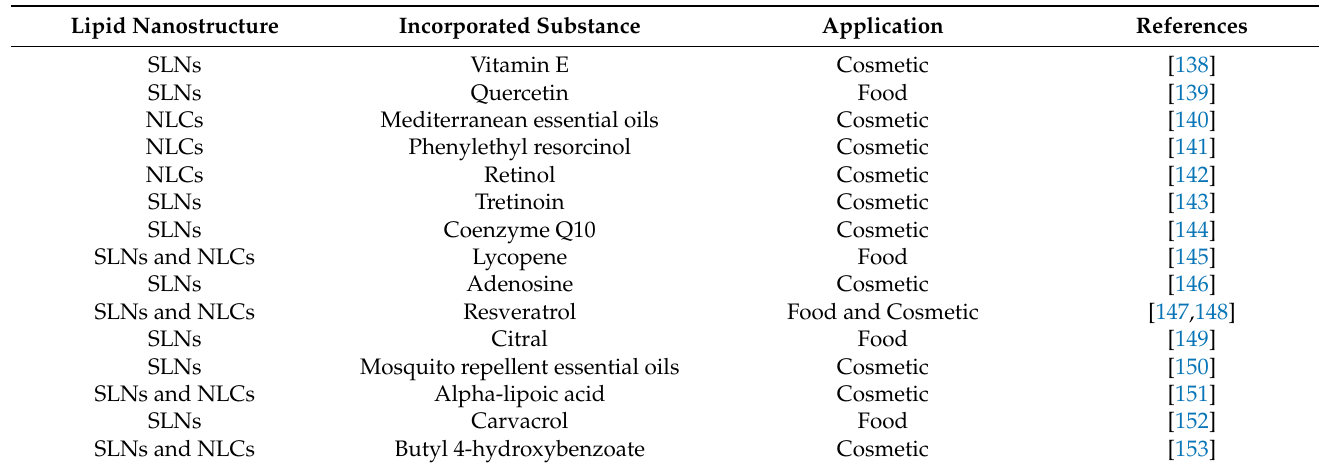
Table 5. Applications of SLNs and NLCs in the food and cosmetics industries.